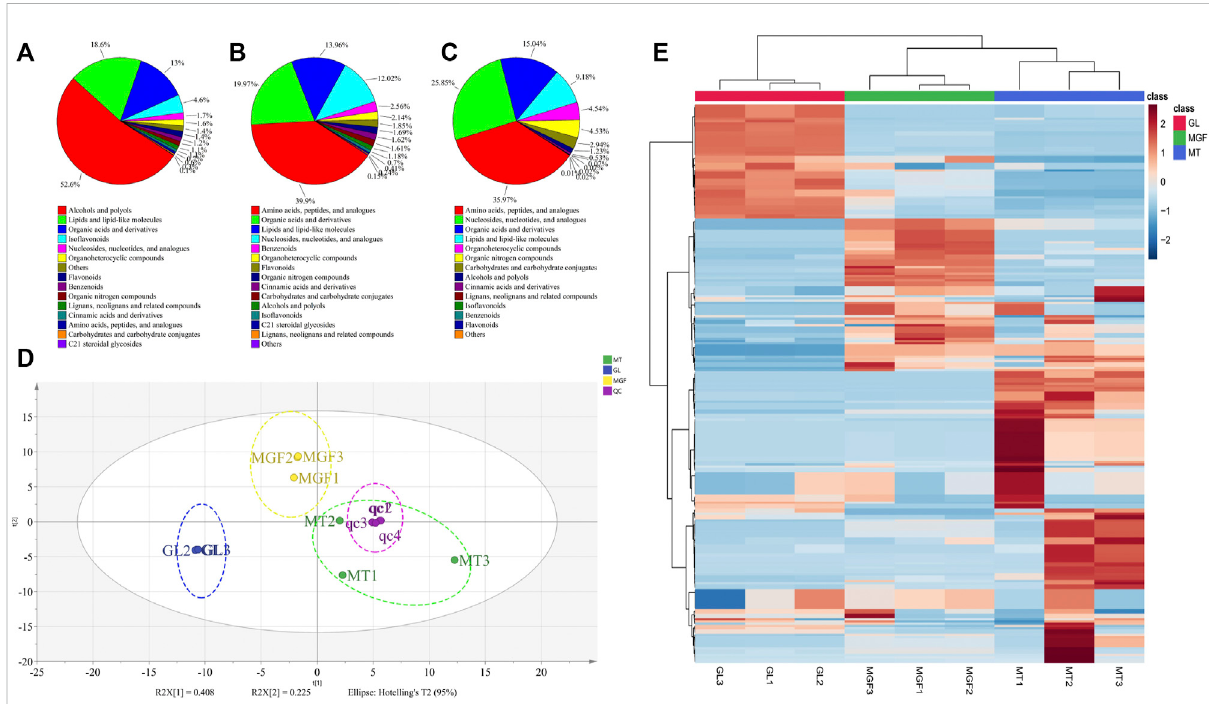
FIGURE 7 Depicting the biochemical categories of the differential metabolites identi fi ed. (A) :MT, (B) :MGF, (C) :GL. (D) : A score plot of the PCA demonstrating distinct metabolomes for MT, GL and MGF. (E) : Cluster analysis of metabolites from samples of MT, GL and MGF. The color indicates the level of accumulation of each metabolite, from low (blue) to high (red). The score represents the deviation from the mean by standard deviation